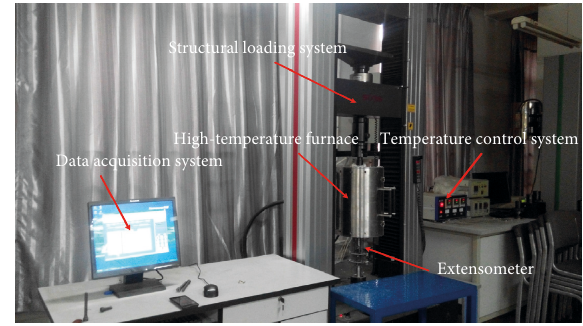
Figure 3: Photograph of the test bed.